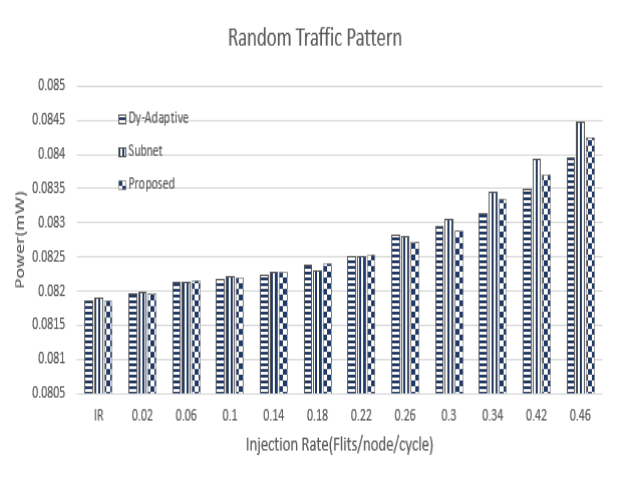
Fig. 16. Power consumption evaluation under synthetic uniform random traffic pattern